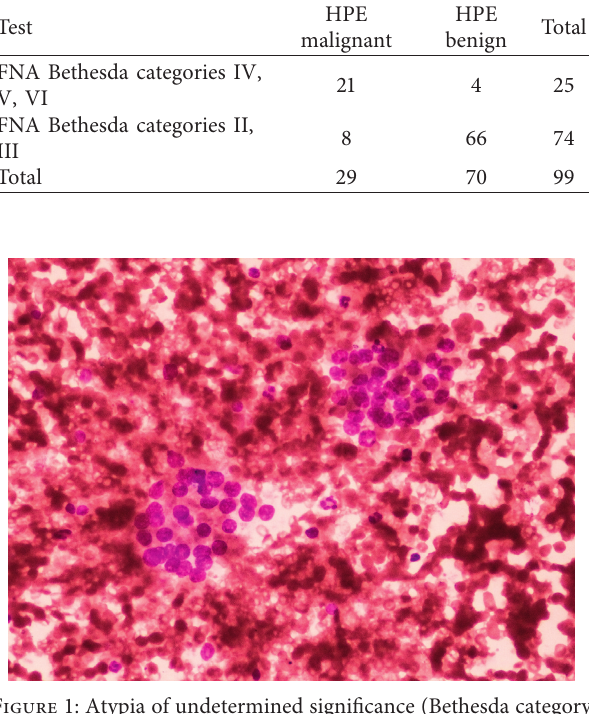
Figure 1: Atypia of undetermined significance (Bethesda category III). Smear shows clotting artefact with crowding of follicular cells hindering the interpretation (MGG stain ×